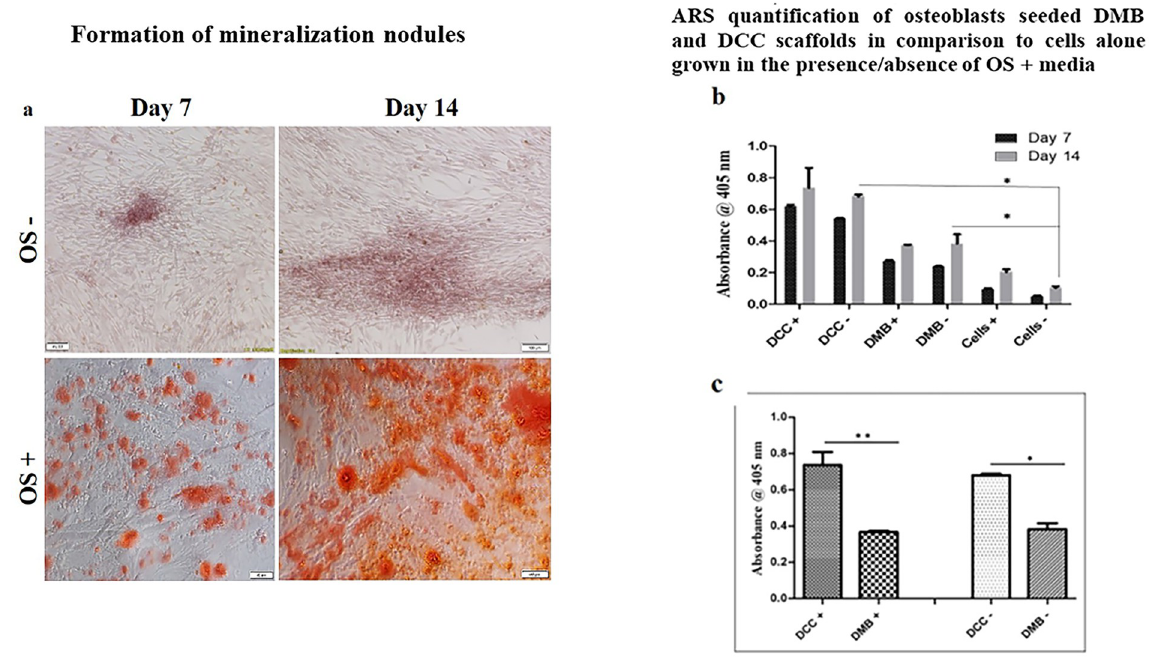
Fig 9. Formation of mineralization nodules. Photomicrographs of HOB cells stained with Alizarin Red S. HOB cells showed increased mineralized nodules in osteogenic medium (OS + ) compared to cells without supplements (OS - ). More significant mineralization was seen by day 14 (a). Quantification of alizarin Red S stained mineralized nodules in human osteoblast cells seeded on DMB and DCC scaffolds grown in the presence or absence of osteogenic induction media at days 7 and 14 in comparison to cells alone is shown; p < 0.001 is indicated). The absorbance of the extracted Alizarin dye was measured at 405 nm. Data presented as mean ± SEM (n = 6) (b). Quantification of Alizarin Red S staining in osteoblast cell-seeded DMB and DCC scaffolds on day 14 in the presence and absence of osteogenic supplements. Data presented as mean ± SEM (n = 4) (c); p < 0.001 is indicated.